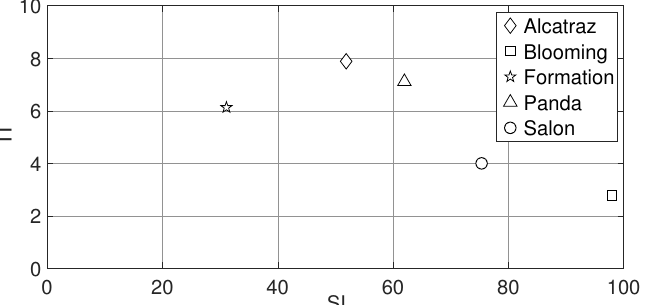
Figure 5. Temporal perceptual information versus spatial perceptual information for the five 360 ◦ cover videos calculated according to Recommendation ITU-T P.910